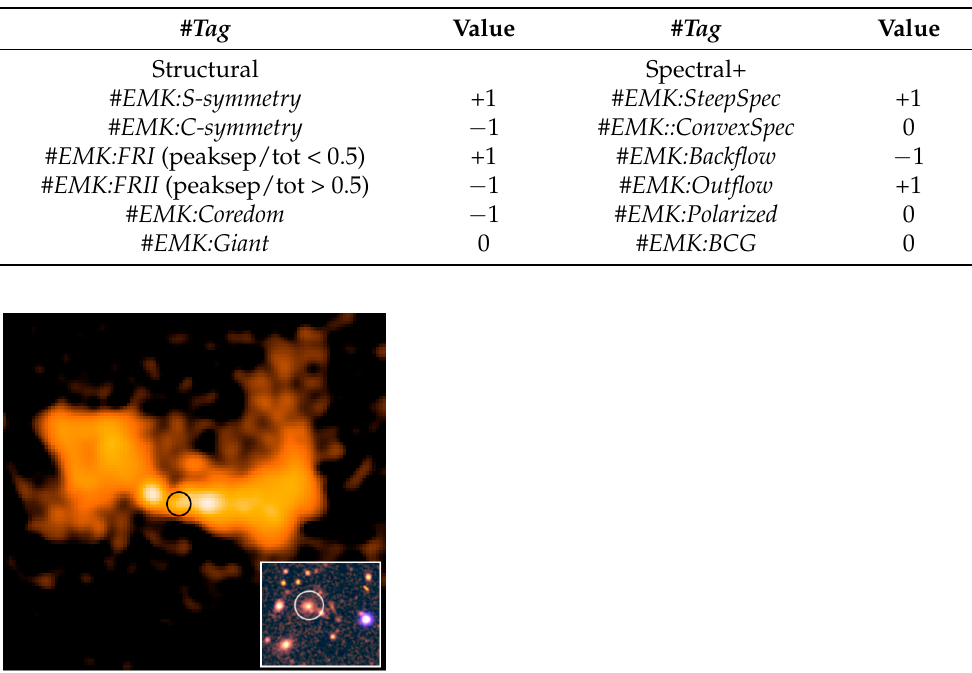
Table 3. # Tag example for source in Figure 2. +1 = satisfied # tag criteria. − 1 = failed # tag criteria. 0 = insufficient information to test # tag criteria. Each # tag is prepended by EMK to identify it with the (fictitious) EMK survey.